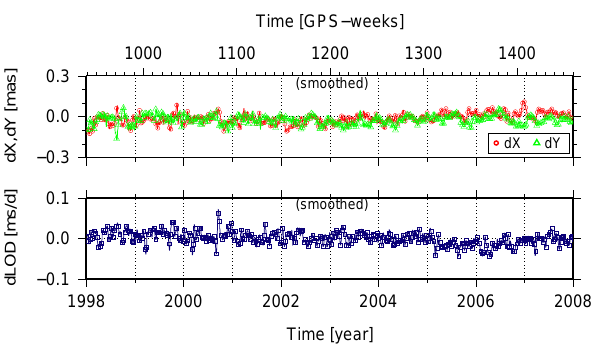
Fig. 5. Standard deviations of the north (N), east (E) and up (U) Fig. 4. Standard deviation of solution residuals weighted average residual weighted average of the GT1 solution with respect to those with respect to IGS combined solution of repro1 (IG1) of the IG1 combined solution of the IGS repro1 campaign.